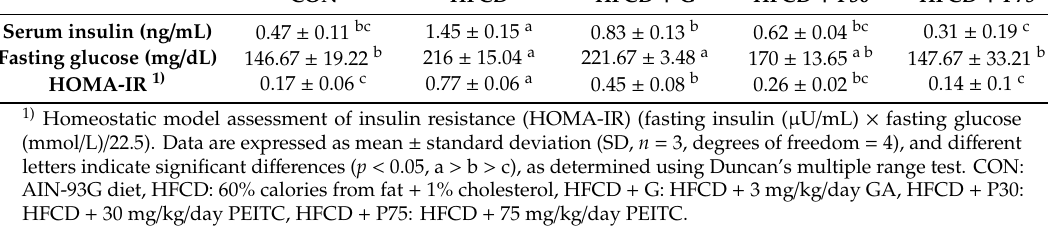
Table 4. E ff ects of PEITC supplementation on insulin, blood glucose, and HOMA-IR.